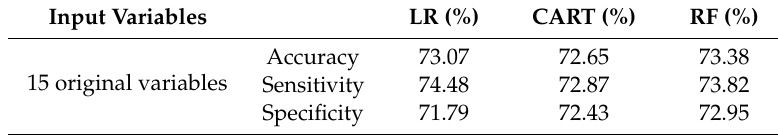
Figure 2. Sensitivity of LR, CART and RF with input of significant variables identified by LR. Figure 3. Specificity of LR, CART and RF with input of significant variables identified by LR. 3.2.3. Accuracy, Sensitivity and Specificity of LR, CART and RF with Input of Important Variables Identified by CART Next, the accuracy of validation datasets of the LR, CART and RF models when the 15 original variables are replaced by 7 groups of significant variables identified by the CART model and the most significant 4 to 10 are kept is illustrated in Table 6 and Figure 4. Only the accuracy of RF increases